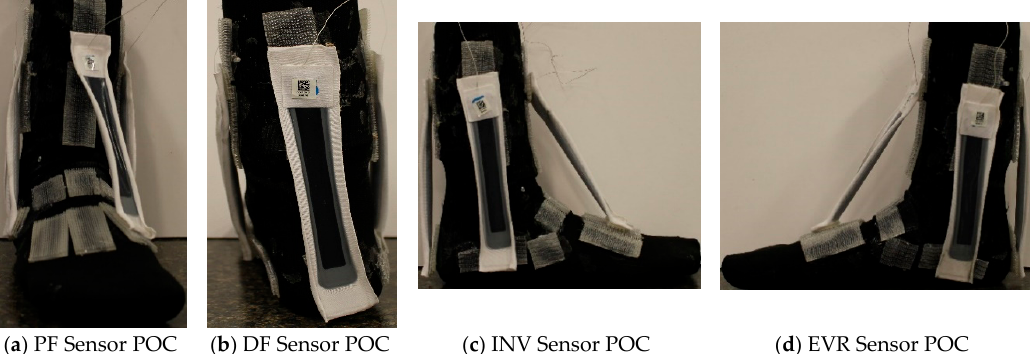
Figure 3. ( a ) Plantar flexion (PF) SRS mounted on the dorsal surface and oriented towards the hallux (big toe) to measure the downward movement of the foot; ( b ) dorsiflexion (DF) SRS mounted on the heel of the foot to measure the upward movement of the foot towards the lower leg; ( c ) INV SRS mounted directly over the lateral malleolus (bony landmark on the lateral side of the ankle) to measure the movement of the sole (bottom of the foot) towards the midline of the body; ( d ) EVR SRS mounted directly over the medial malleolus (bony landmark on the medial side of the ankle)